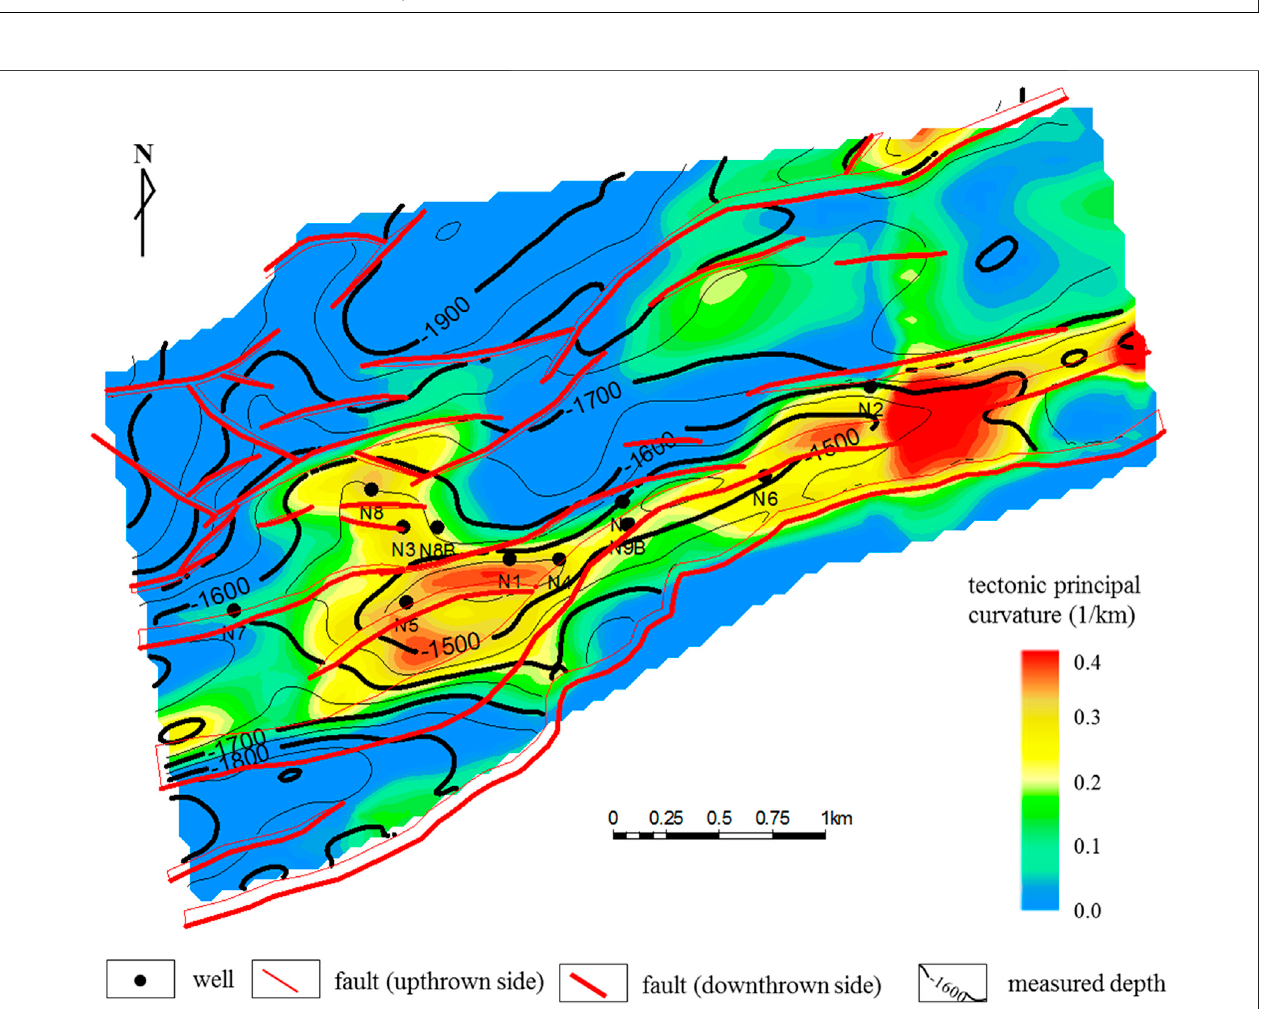
FIGURE 10 | Distribution of the tectonic principal curvature at the top surface of the Carboniferous in the Weizhou 1 – N oil fi eld.